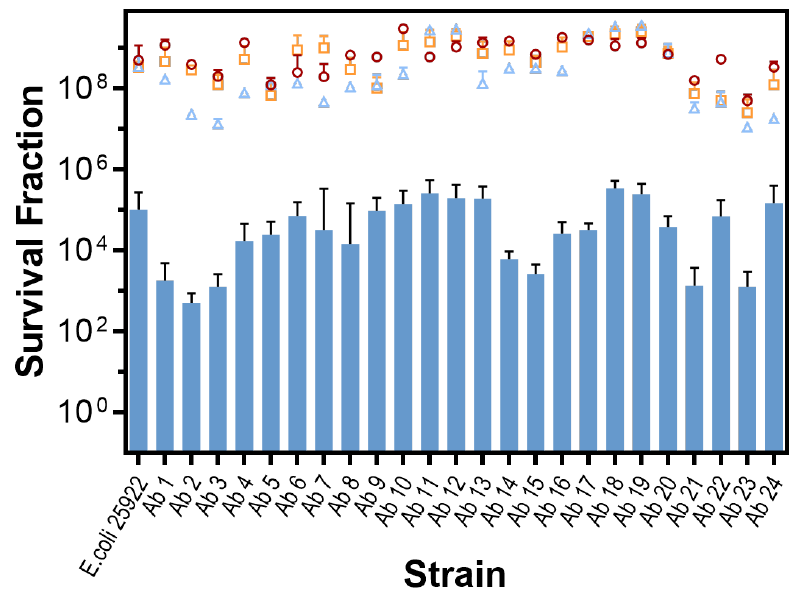
Figure 2. In vitro inactivation of E. coli growing in biofilm state (18 J / cm 2 at 625 ± 25 nm, 78 µ M MB concentration). Survival fractions are presented as mean + standard deviation (SD). Circles : cell control (BF1 − L − MB); triangles : light control (BF2 + L − MB); squares : MB control (BF3 − L + MB); bars : test (BF4 + L + MB).